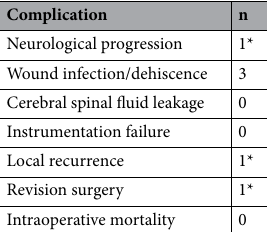
Table 4. Postoperative complications. *These complications occurred in the same case.